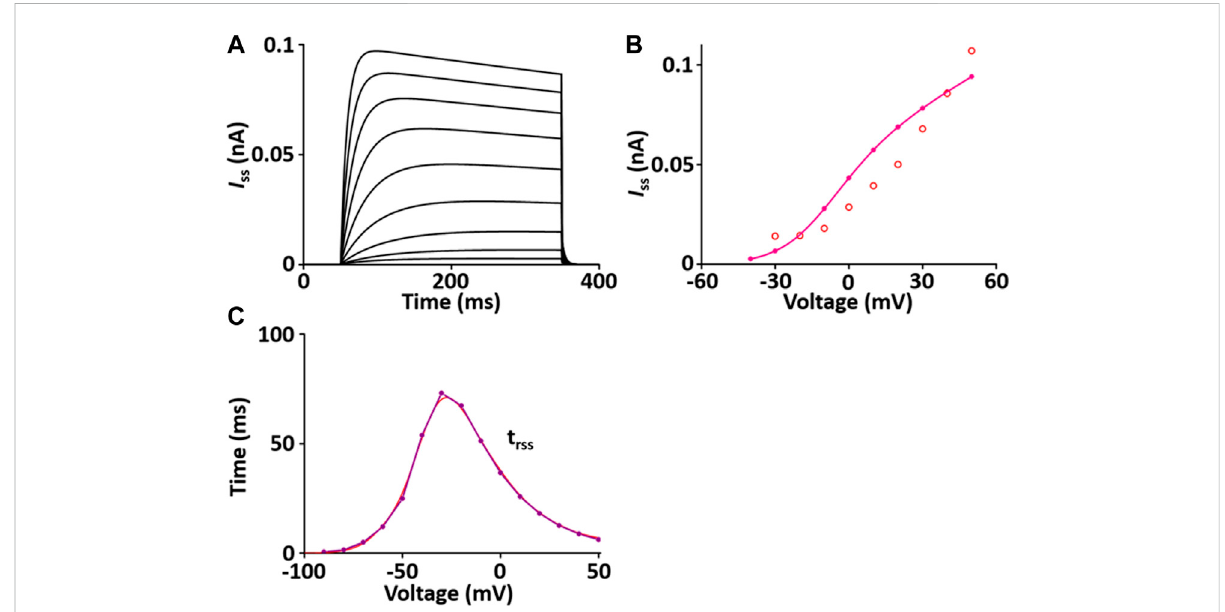
FIGURE 3 Veri fi cationof I ss implementation(Kim,2018). (A) Simulatedcurrenttracesofthesteady-stateoutwardK + channel. (B) Simulated I-V relationship of I ss (pink line). This simulated result is in close agreement with therepresentative experimental result (o, Clark et al. (1995)). (C) Simulatedactivation timeconstant( τ rss ,purpleline).Thissimulatedresultisincloseagreementwiththerepresentativeexperimentalresult(redline,ApkonandNerbonne (1991)), which is 10 times slower than the corresponding one for I to (Figure